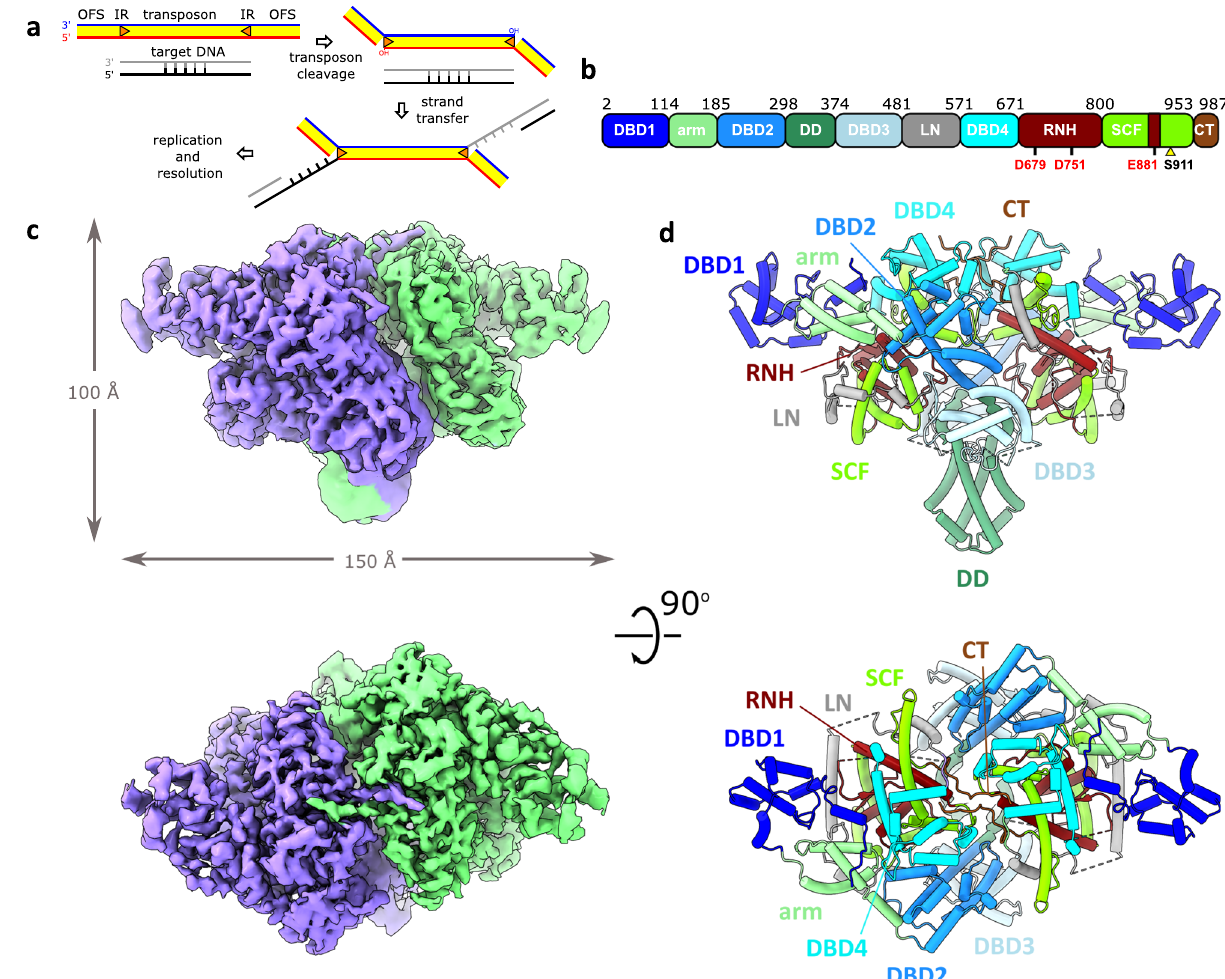
Fig. 1 | Function and architecture of TnpA. a Schematic of paste-and-copy transpositionpathwayofTnpA. b LineardiagramshowingsubdivisionofTnpAinto structuraldomains.DBD1-4DNAbindingdomains1 – 4,DDdimerizationdomain,LN linker domain, RNH RNase H-like catalytic domain, SCF scaffold domain, CT C-terminal tail. Positions of the catalytic DDE triad and activating mutation are